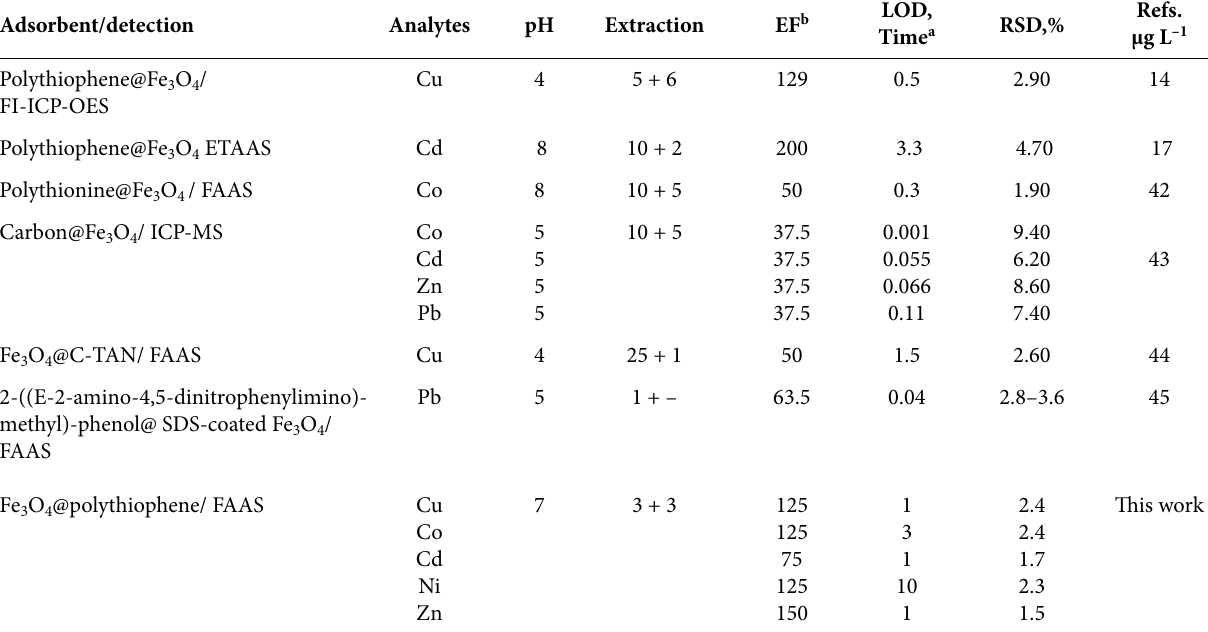
Table 8. Comparative data from some recent studies based on use of the coated Fe 3 O 4 Adsorbent/detection Analytes pH Extraction